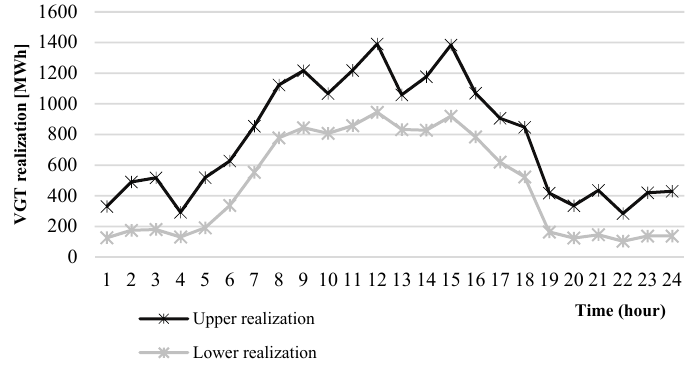
Figure 3. Considered realizations of VGT. Table 3. Total operation costs for each realization of VGT. Comparison between Robust Unit Commitment (RUC) and Frequency Control Robust Unit Commitment (FC-RUC)